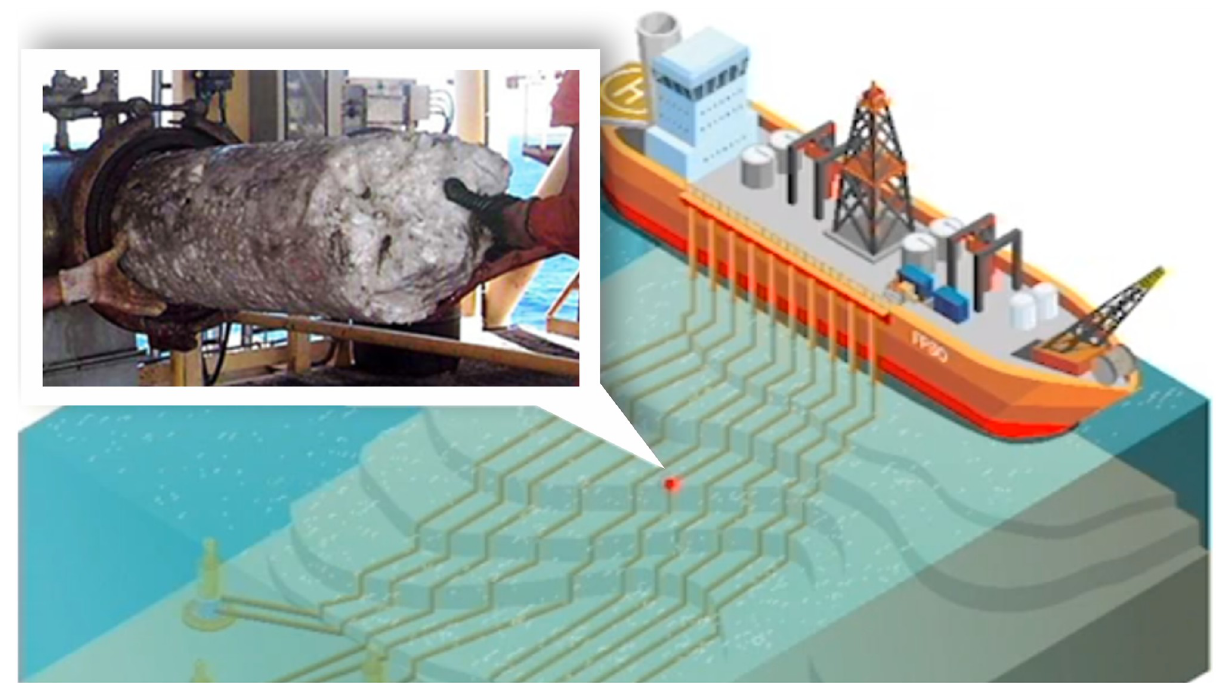
Fig 1. Hydrates and paraffins. The most common duct obstruction